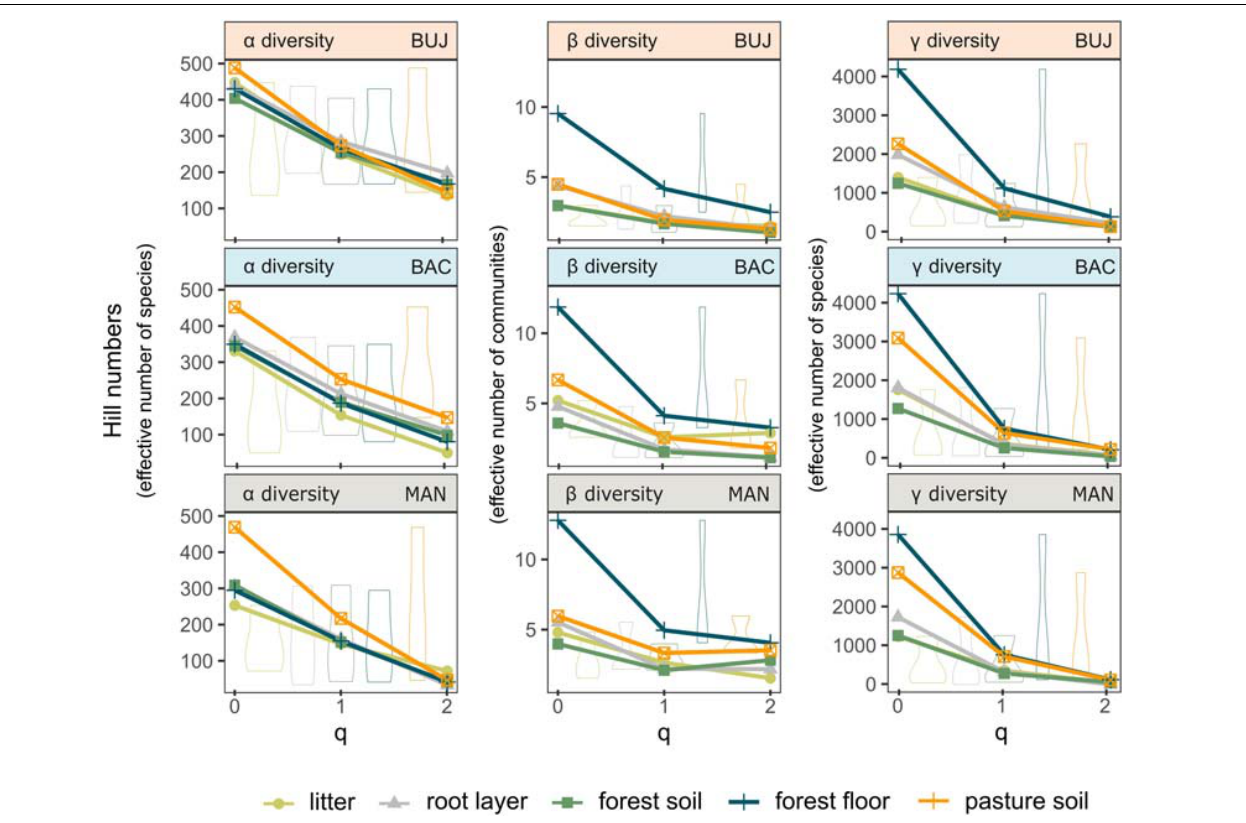
FIGURE 6 | Diversity partitioning analysis evidencing the heterogeneity of prokaryotic metacommunity across land uses. Alpha ( α ), beta ( β ), and gamma ( γ ) (i.e., local, community, and regional) diversities for the forest and pasture bulk soils, litter, root layer, and the forest floor in each site. Hill numbers ( q = 0, ASV richness), ( q = 1, exponential of Shannon’s entropy for equally weighted ASVs), and ( q = 2, inverse of Simpson index for dominant